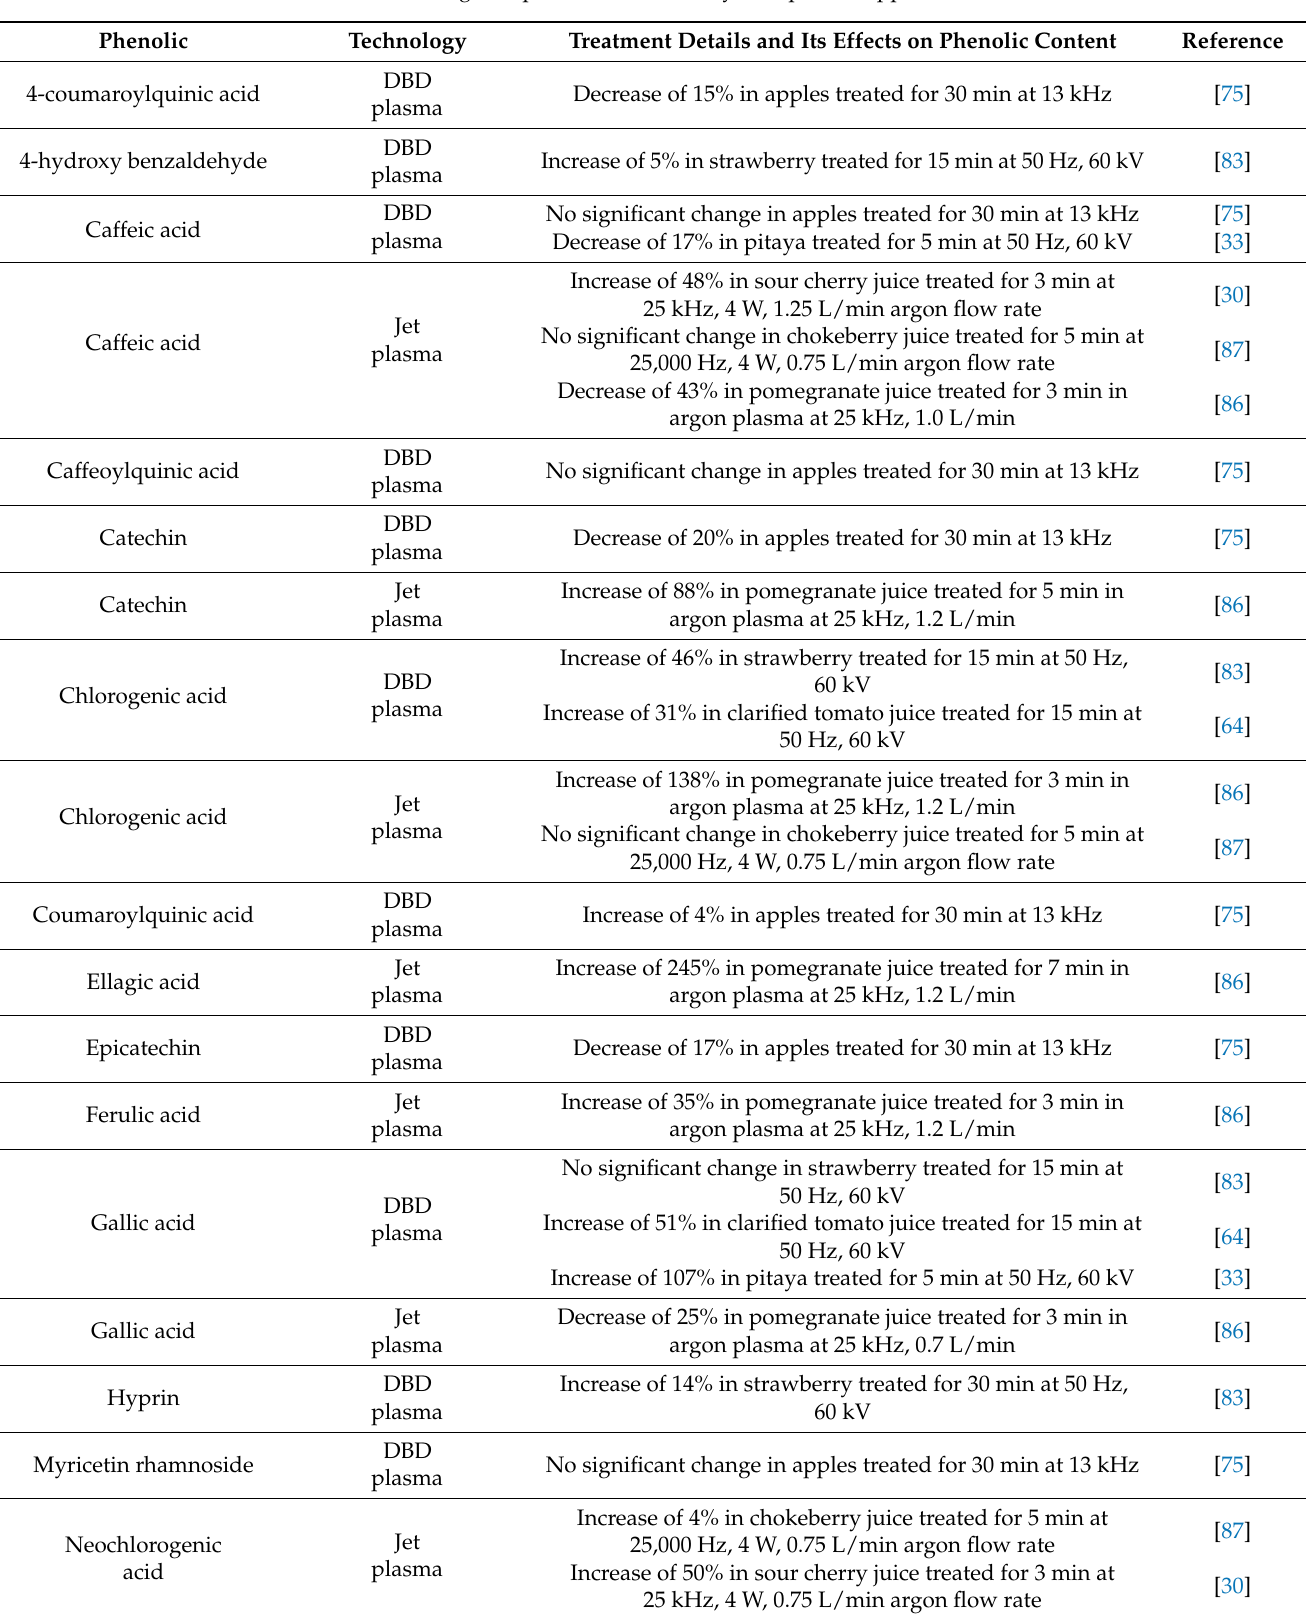
Table 4. Changes in phenolics induced by cold plasma